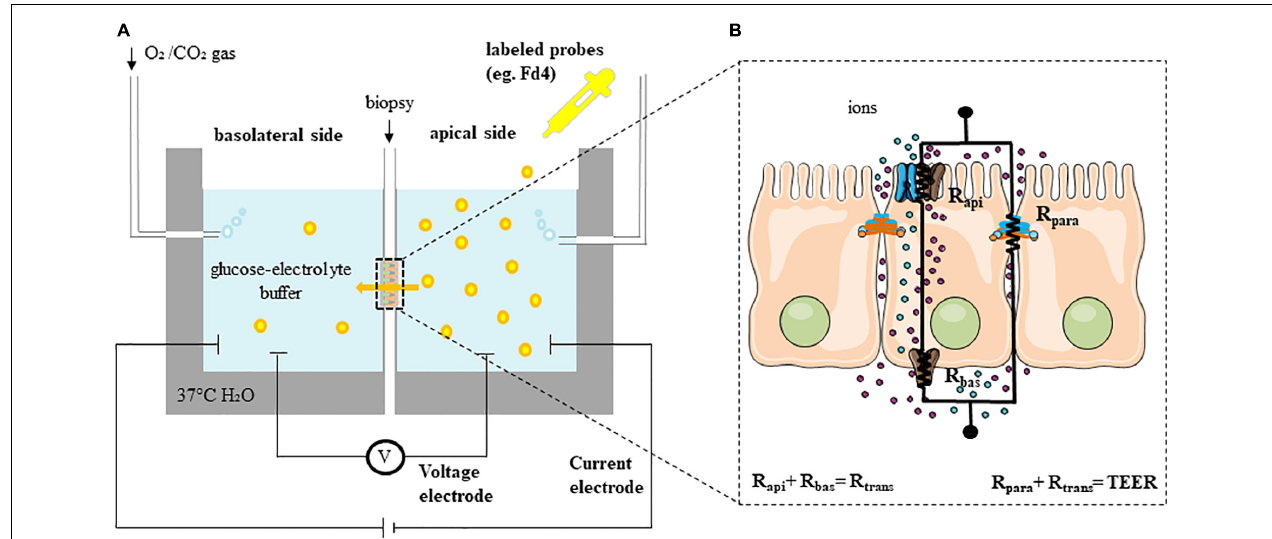
FIGURE 2 | Functional assessment of permeability ( ex vivo ). (A) Experimental set-up of Ussing chambers. (B) Equivalent electrical circuit model with the transcellular (R trans or sum of apical (R api ) and basolateral (R bas ) resistances) and the paracellular (R para ) resistances in a simple epithelium (TEER is the sum of all individual resistances). Fd4, fluorescein isothiocyanate-labeled 4 kDa dextran; TEER, transepithelial electrical